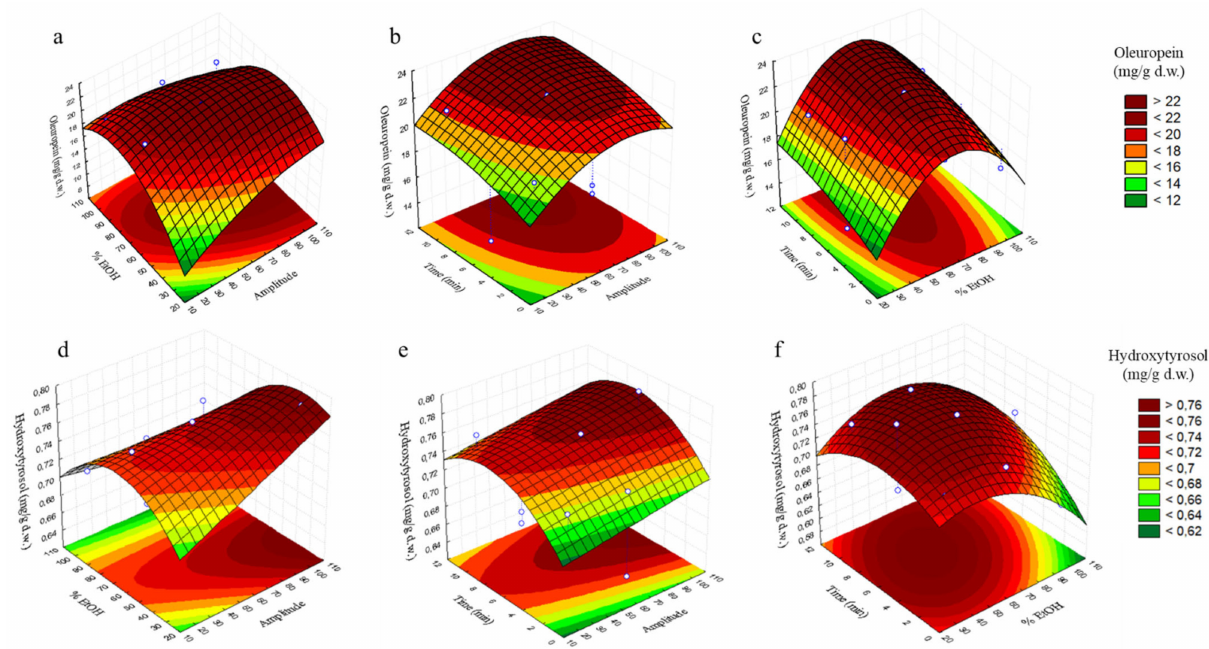
Figure 1. Response surface plots showing combined effects of process variables for oleuropein and hydroxytyrosol (mg/g d.w.): amplitude—% EtOH ( a , d ), amplitude—time (min) ( b , e ) and % EtOH—time (min) ( c , f ).